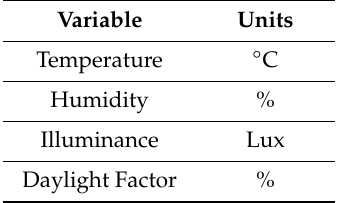
Table 8. Nomenclature table with units.